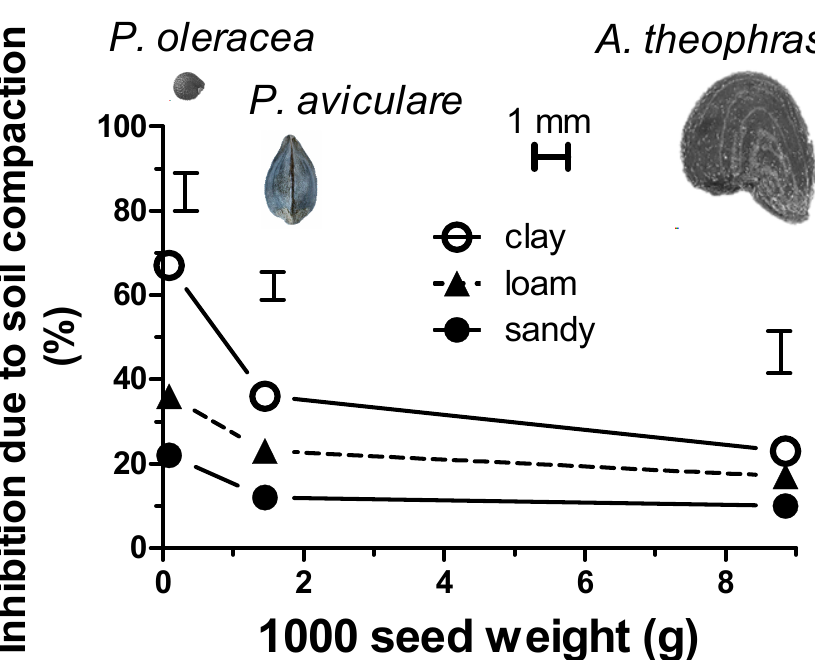
Figure 3. Emergence inhibition due to soil compaction (difference between tilled and compacted soils of the three different soil textures) as a function of the 1000 seed weight of the selected weed species. For all species, the inhibition was calculated at a sowing depth of 2 cm. The horizontal bar indicates 1 mm in order to provide reference for the real seed size. Vertical bars indicate the LSD (Least Significant Difference) values in the Student–Newman–Keuls test ( p < 0.05).